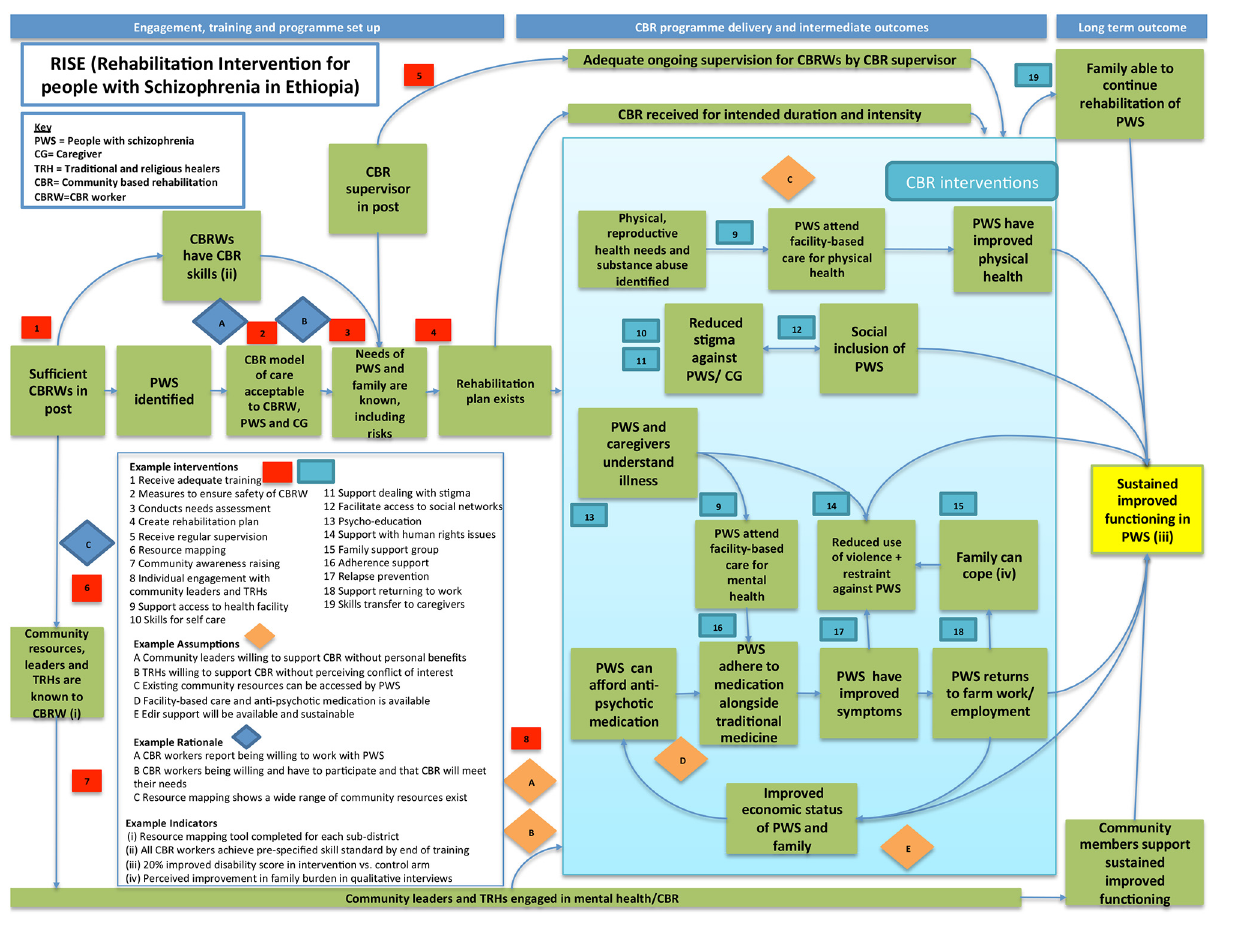
Fig 1. RISE Theory of Change